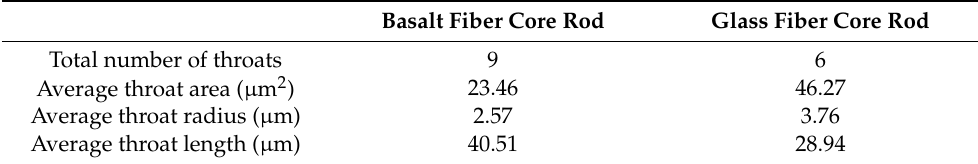
Figure 15. Different volume porosity content in two types of core rods. Table 3. Pore throat characteristics of basalt fiber core rods and glass fiber core rods. Basalt Fiber Core